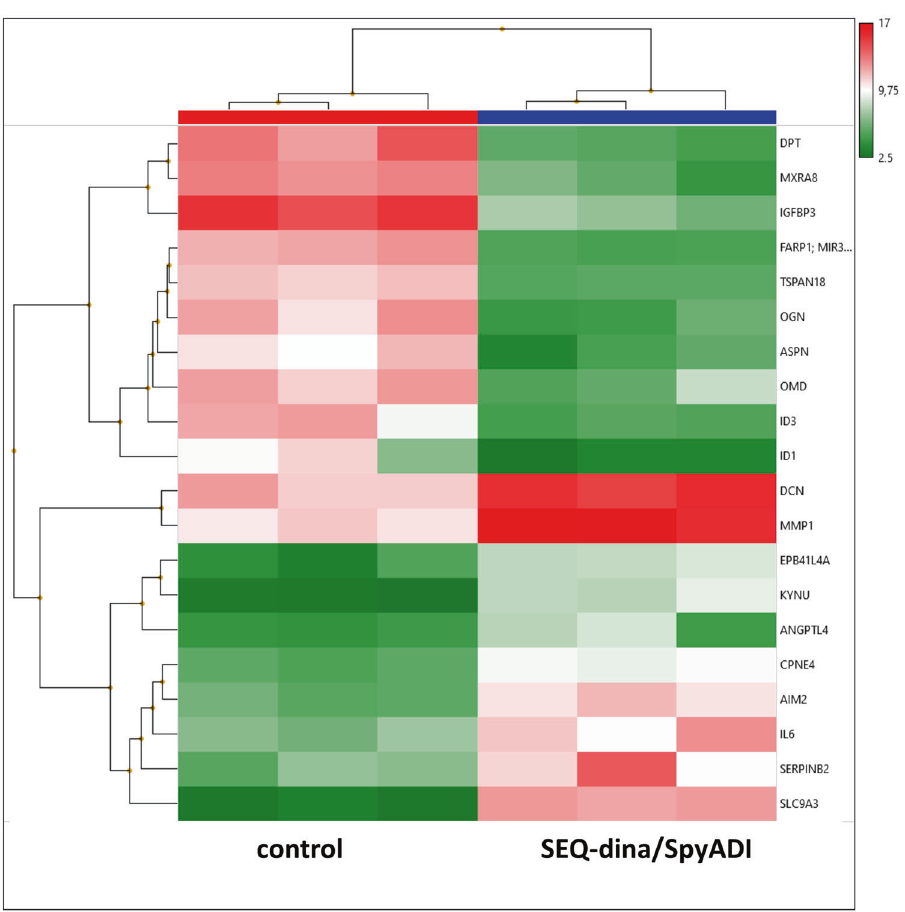
Fig. 7 Heat map showing RNA expression level from 2D-cultured HROG63 cells. Therefore, cells were either treated with SEQ-dinaciclib/ SpyADI or left untreated. RNA was isolated as described in material and methods and RNA expression level determined by applying Affymetrix Human Clariom S Array. Primary data analysis was performed with the Affymetrix TAC including the SST-RMA for normalization. Gene expression data were log-transformed. Limma was used here to calculate the p -value. A change was considered signi fi cant when the Limma eBayes p -value met the criterion p < 0.05 at fold-changes > |2 | , i.e., expression increments or declines larger than two. Data are collected from three independent